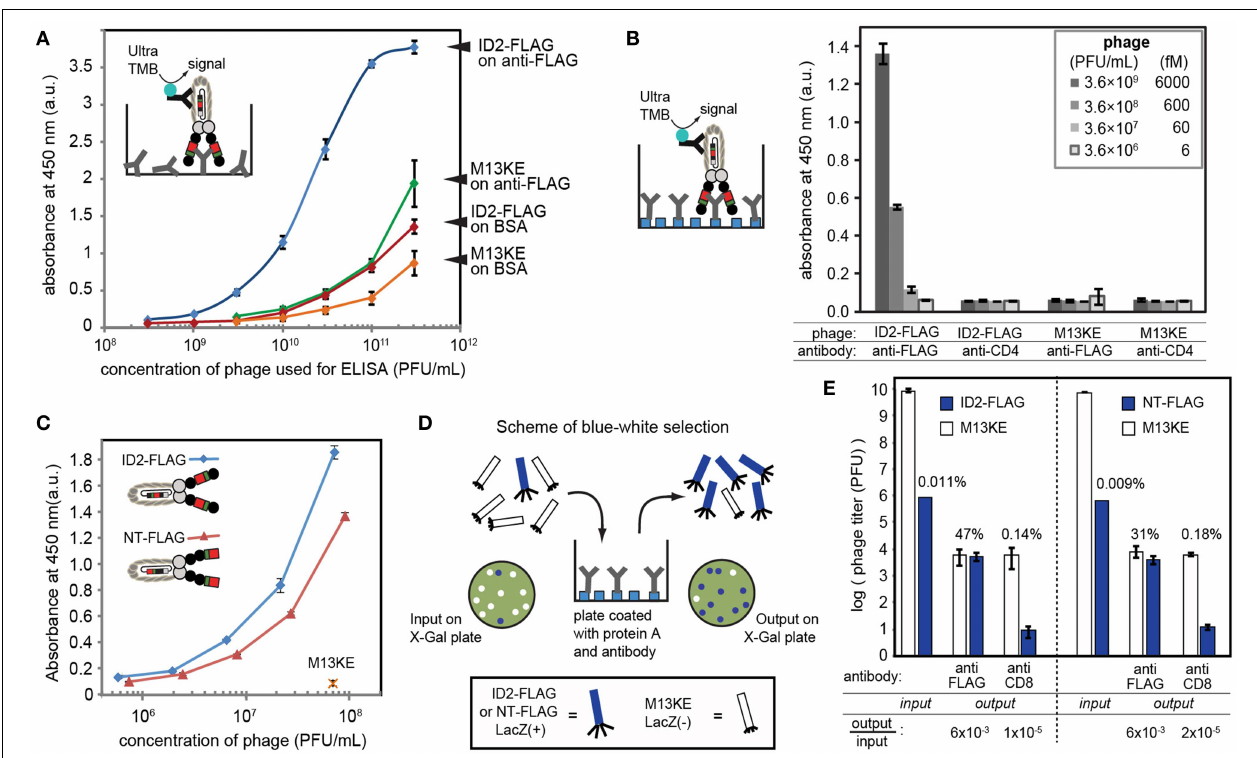
N-terminus (NT) and in intra-domain (ID) fashion using setup analogous to (B) . ID-display provides statistically significantly higher signal at equivalent titers. (D) Scheme of selection of ID-FLAG or NT-FLAG from a 1:10,000 mixture with insert-free phage. Enrichment is monitored as increase of blue (LacZ + ) plaques on agar overlay containing X-gal. (E) Results of selection of ID-FLAG or NT-FLAG on wells presenting anti-FLAG or anti-CD8 (negative control). ID-display provides minor yet detectable advantage. Input to output ratios for insert-containing clones are displayed below the plot. In all experiments, data represents average from three to four independent wells; error bar is one standard